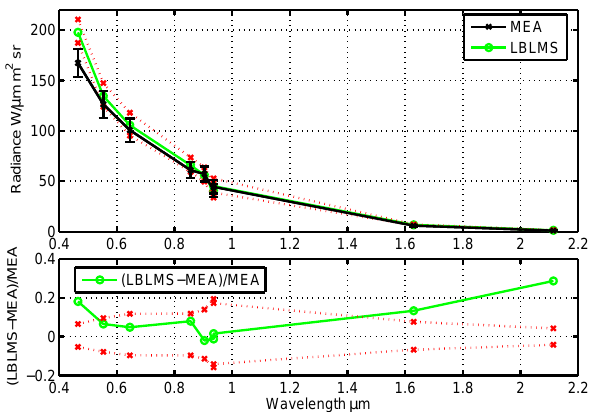
Fig. 23. LBLMS and MODIS radiances for Area Ci1. Upper panel: the black line connects measured MODIS values; the black bars de- note the (2 σ ) variability around the mean measured radiance corre- sponding to same retrieved OT for the area. The green line connects the simulated values (open green circles); the dashed red lines are the radiance computed with OT varied by twice the 1 σ value given in Table 2 and thus denote the 2 σ uncertainty level. Lower panel: fractional difference (green line and open circles); the red dashed lines are the 2 σ uncertainty level.